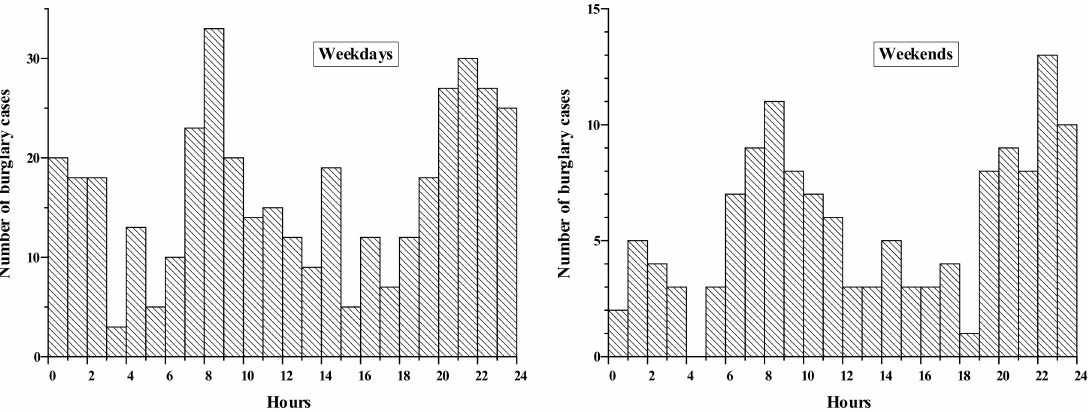
Figure 4. The number of burglary cases in each time